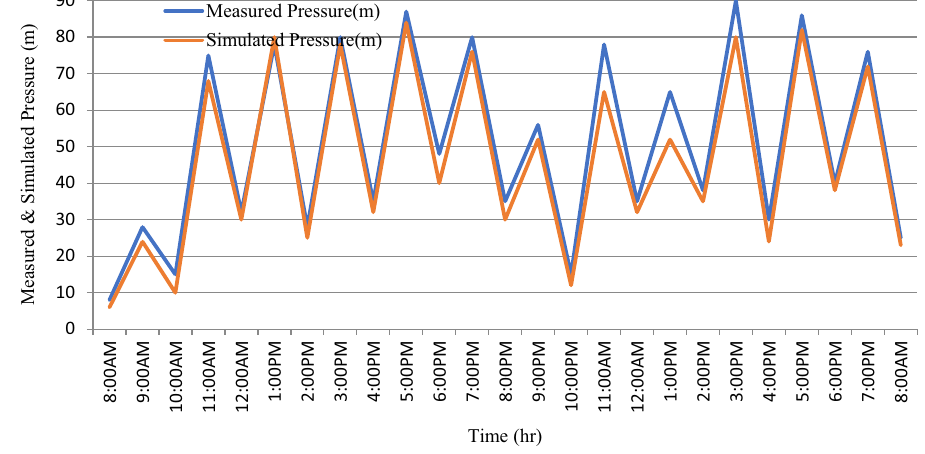
Fig. 5 Validation model of measured and simulated pres- sures at average daily demand